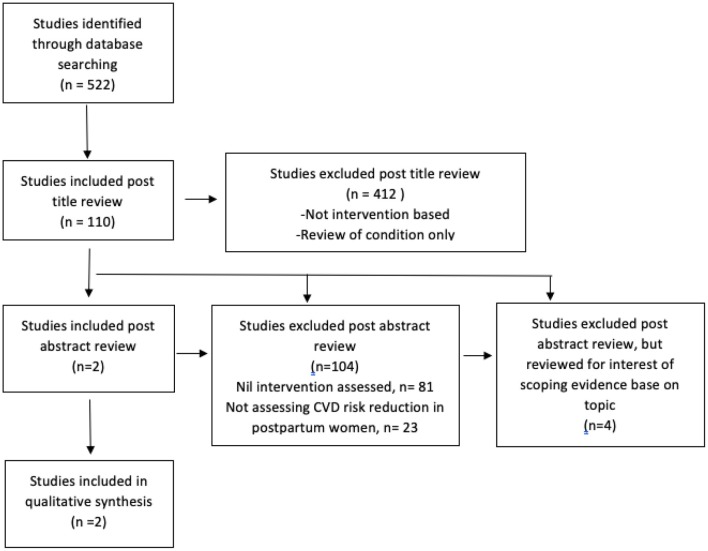
PRISMA flow chart (14).